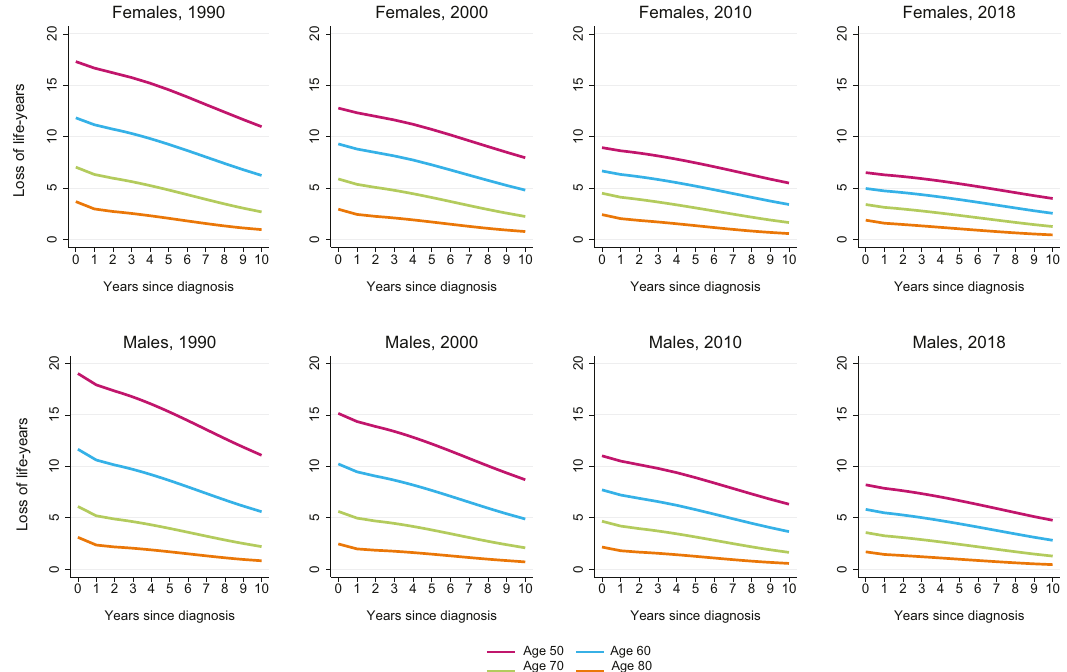
Fig. 2 The conditional loss in expectation of life of patients with chronic lymphocytic leukemia diagnosed in the Netherlands. The conditional loss in expectation of life (CLEL) is presented according to four age categories at diagnosis, strati fi ed by sex, and four selected calendar periods of diagnosis. The projected measures of life expectancy according to age categories are presented in Supplementary Table